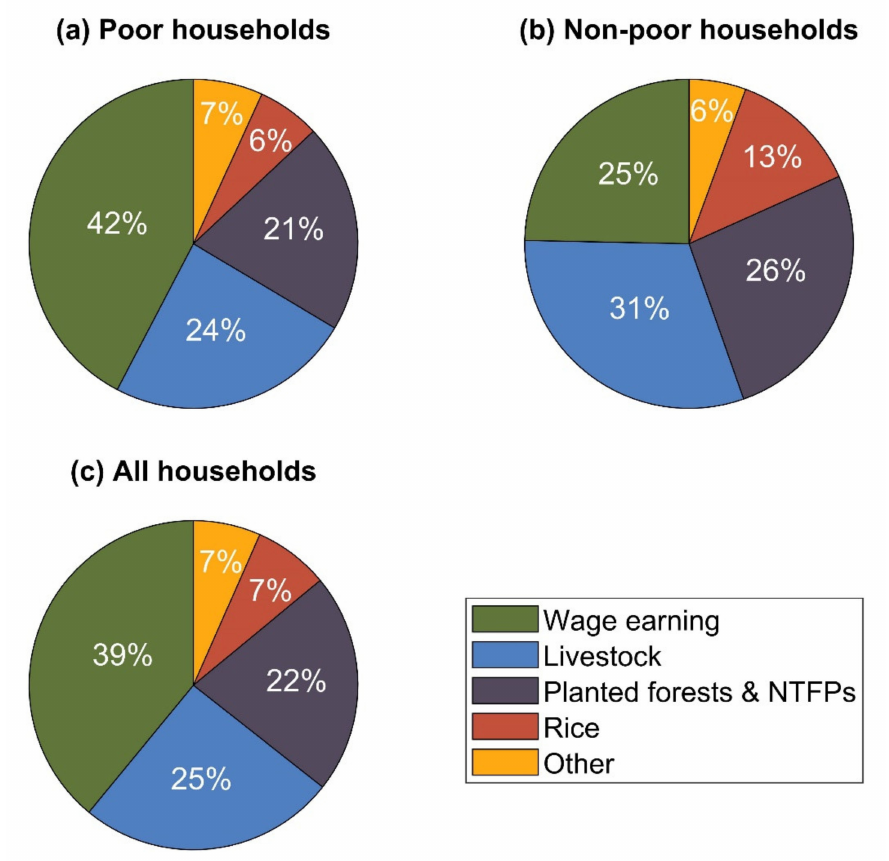
Figure 4. The household income structure. Source [30,36,41].